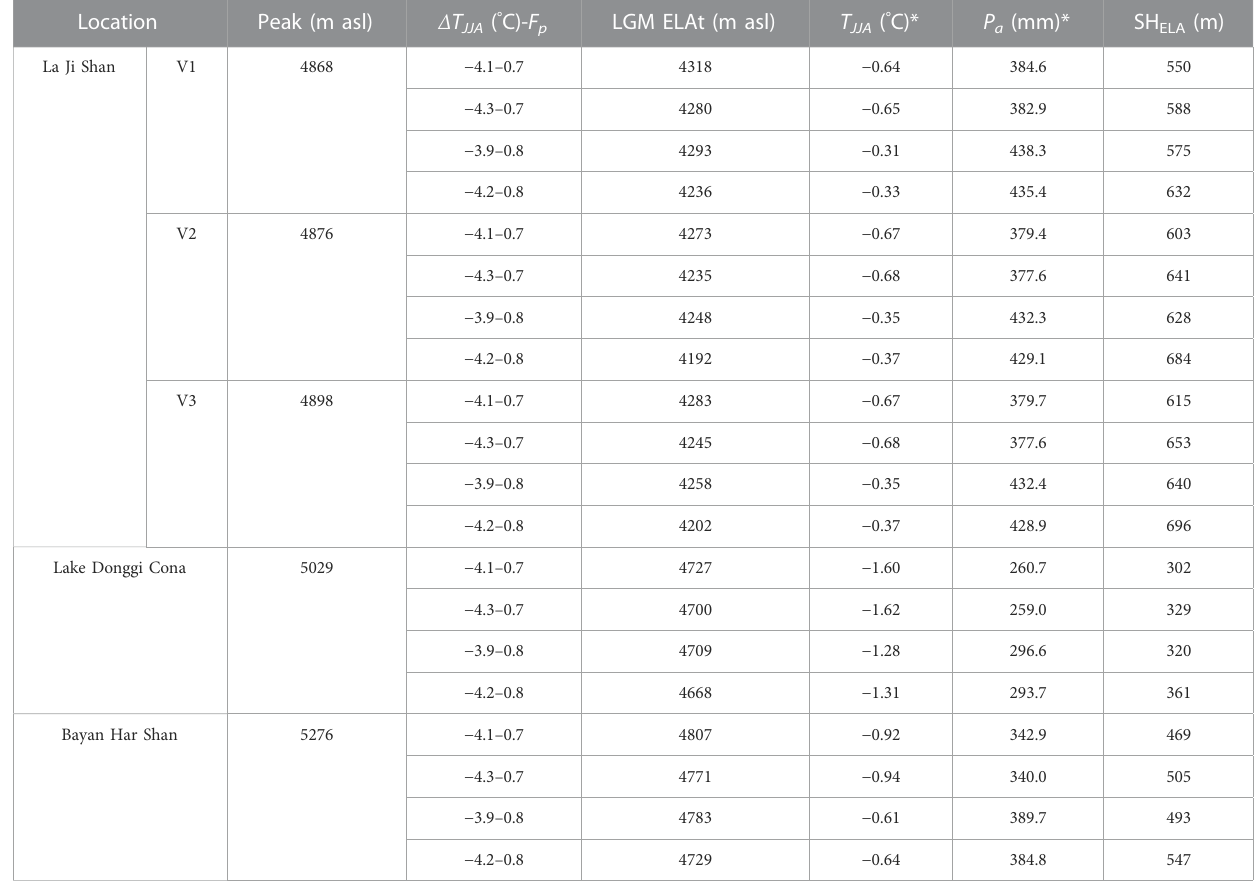
TABLE 3 Factors controlling glacier development in the La Ji Shan, Bayan Har Shan, and Lake Donggi Cona.